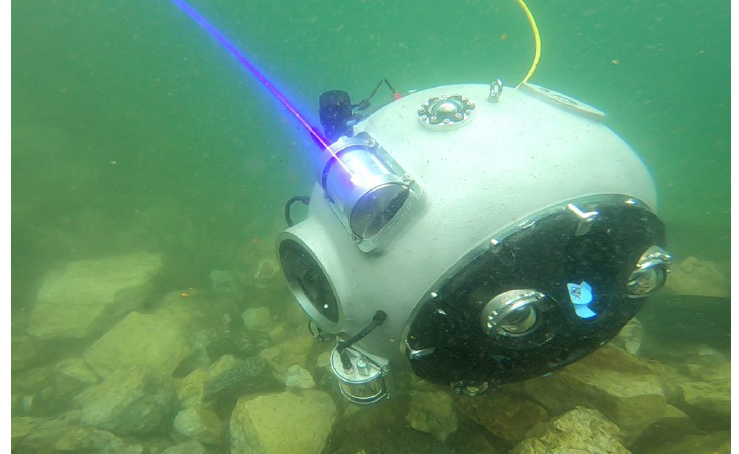
Figure 2. The UX-1 prototype during operation in Kaatiala Mine (Finland). Image credits: UNEXMIN, www.unexmin.eu, (Accesed: 30 December